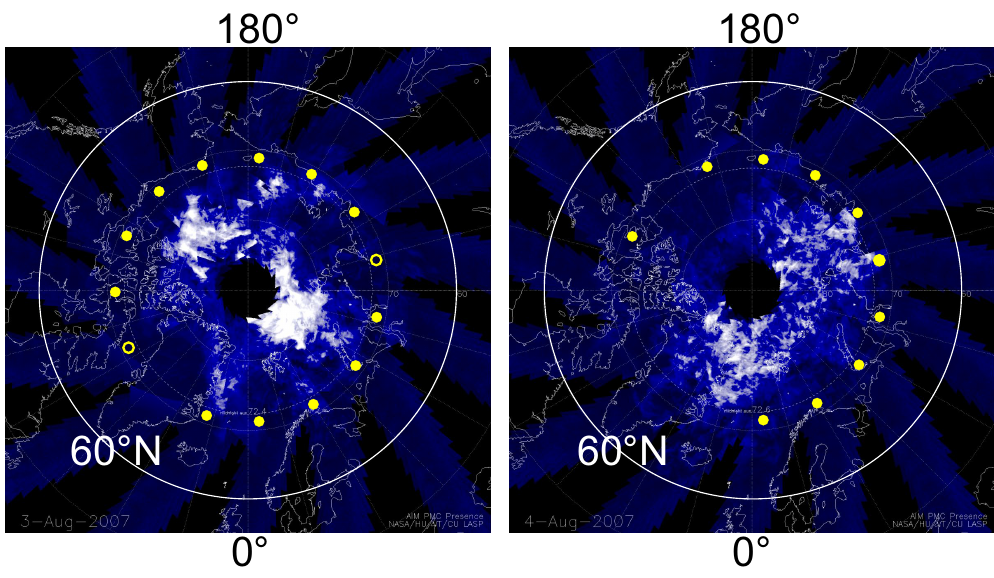
Fig. 3. A detailed view of PMC in the Northern Hemisphere on August 3 (left) and 4 August (right) 2007 by the CIPS experiment on AIM. The blue area is covered by the CIPS cameras with a resolution of 5 × 5km per pixel. The white regions are PMC measured by CIPS. Yellow circles mark measurements performed by the SOFIE instruments (see Fig. 4). Filled yellow circles indicate the detection of PMC by